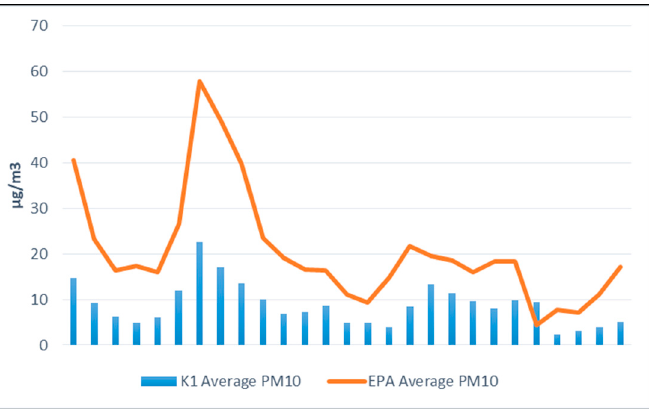
Figure 2 . A correlation analysis of the PM 10 data gathered by EPA’s sampler and K1 low-cost sen- sors for the experimental period from 20 August to 15 September 2022. for the experimental period from 20 August to 15 September